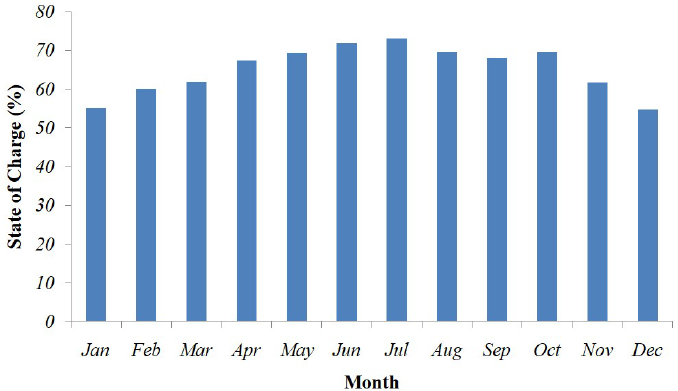
Figure 19. Monthly profile of SOC of battery for PV-Wind-BSS-DG configuration.